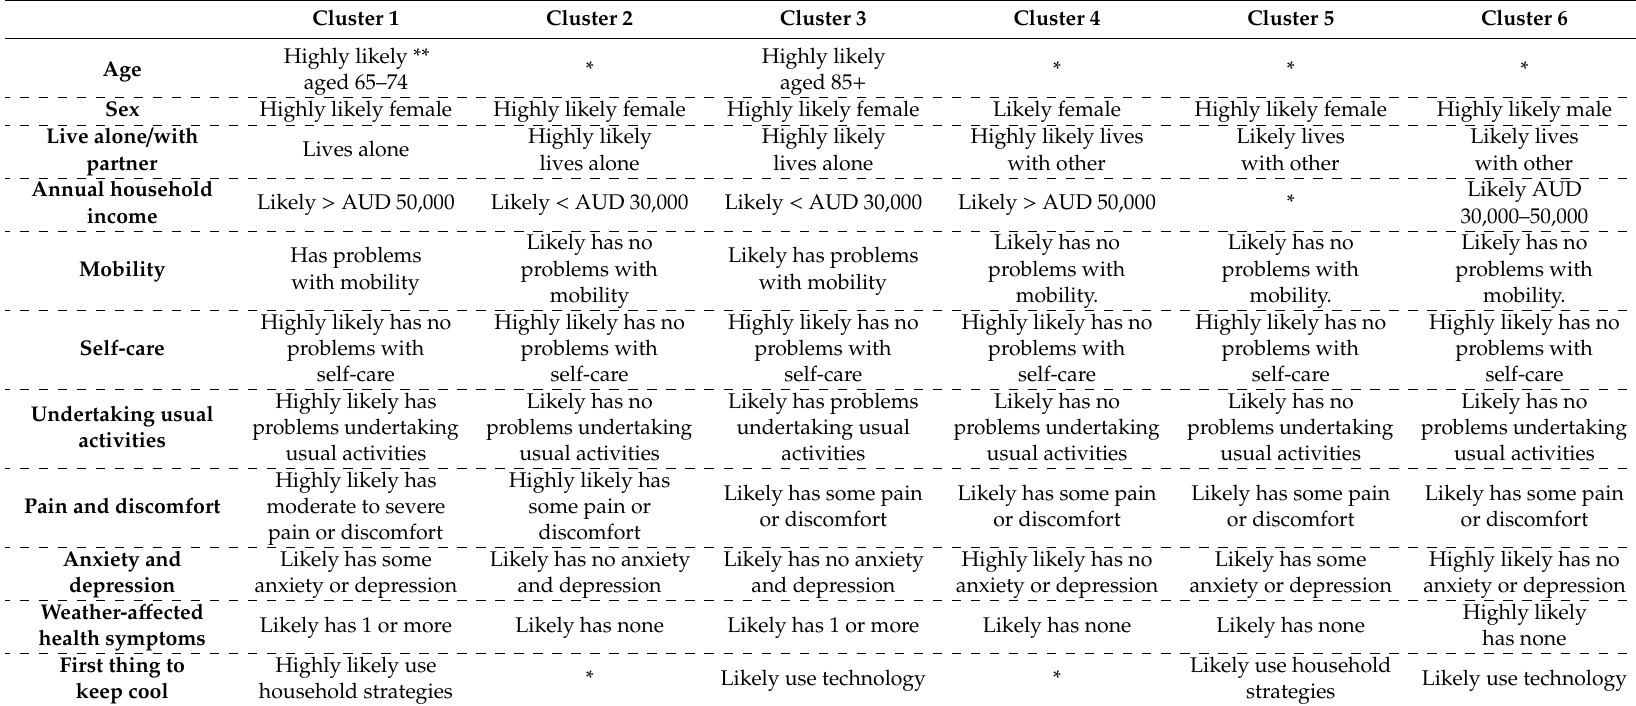
Table 3. Salient characteristics of